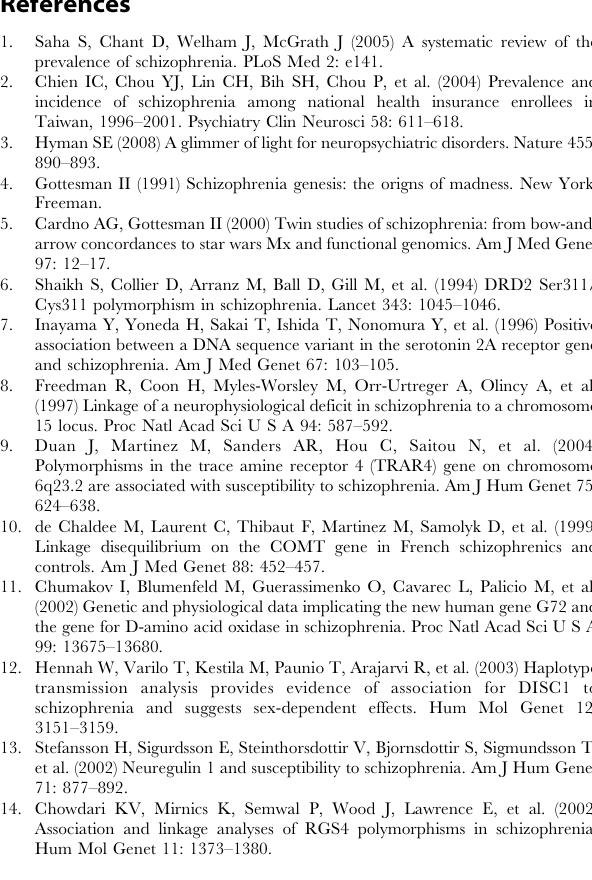
Figure S6 Quantile-quantile (QQ) plots. QQ plot is shown for the trend test. P -values are based on the 694,436SNPs which passed quality filters from 522 cases and 806 controls. The upper and lower boundaries of the 95% confidence bands are represented by the blue lines. Table S1 Quality control of the genotyping results. Breakdown of the number (N) of SNPs and samples which passed the QC filter. Table S2 Concordance rates for the 19 SNPs with significant associations in the initial GWA analysis. Table S3 Multipoint/haplotype analysis of the clusters on